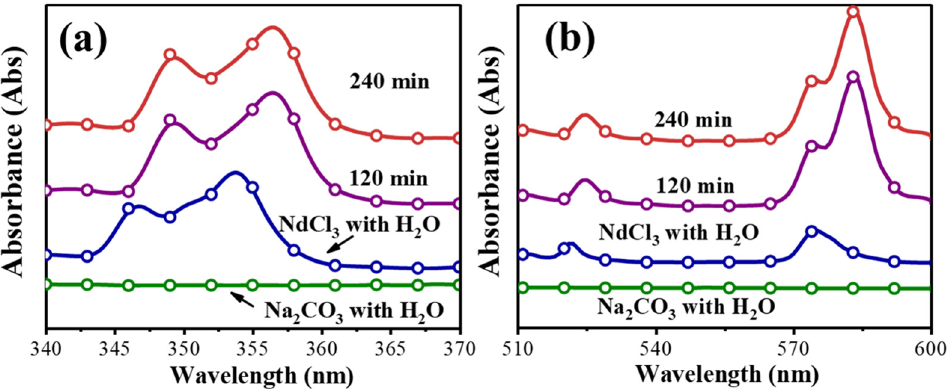
Figure 3. UV-vis spectrum of NdCl 3 /Na 2 CO 3 solution with the addition of 0.5M NaCl, wavelength ( a ), and 510 to 600 nm in ( b in 340 to 370 nm in ( a ), and 510 to 600 nm in ( b ).